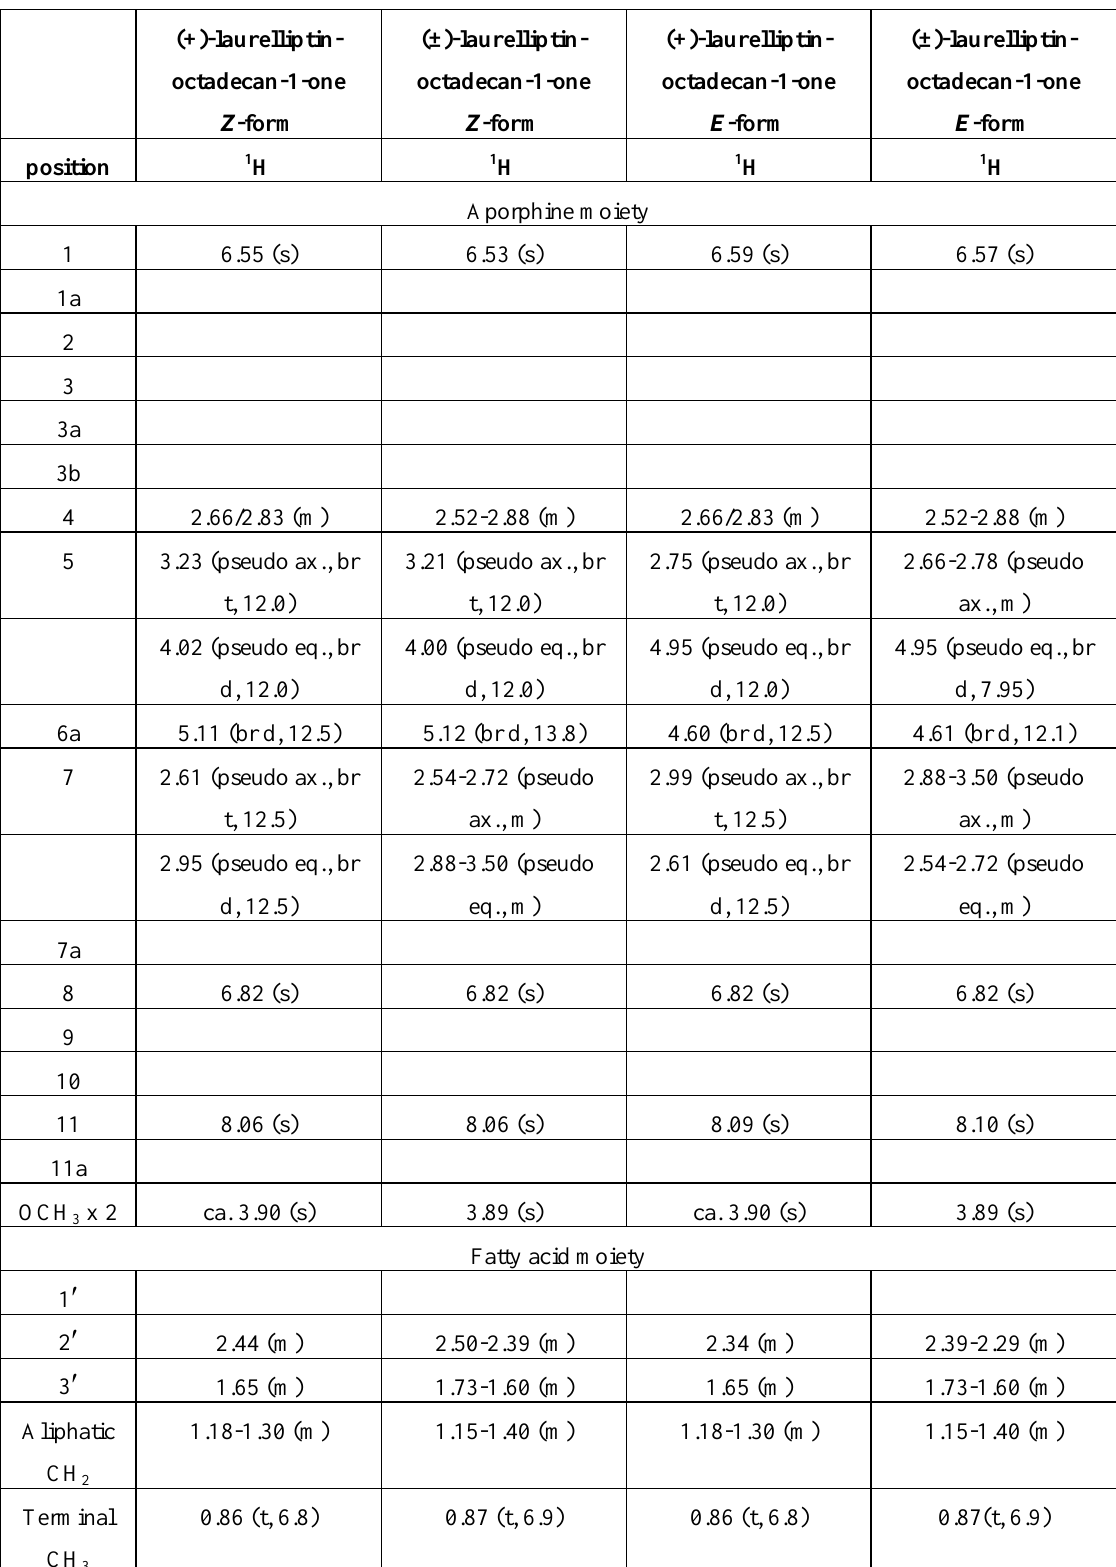
Table 3. Comparison of 1 H-NMR spectral data between (+)-laurelliptinoctadecan-1-one (600 MHz, CDCl ) and (±)-laurelliptinoctadecan-1-one (300 MHz, CDCl 3